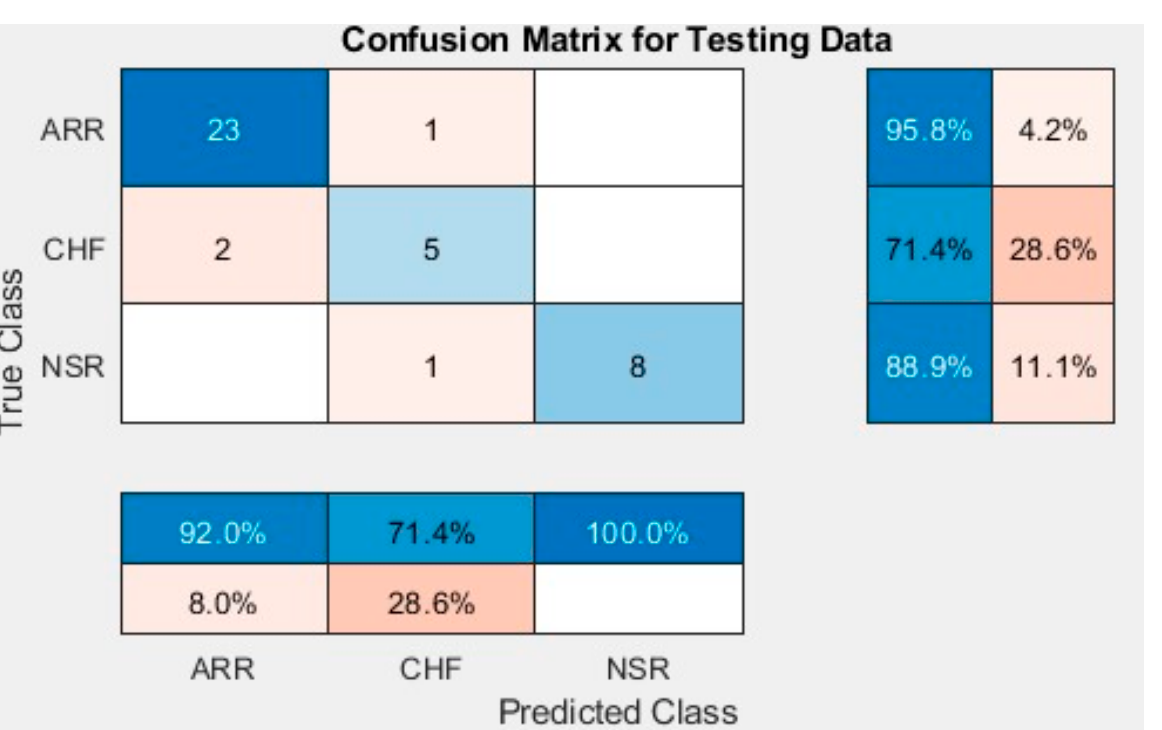
Figure 14. Confusion matrix for the validation set of the proposed hybrid BA-CNN-LSTM algorithm.